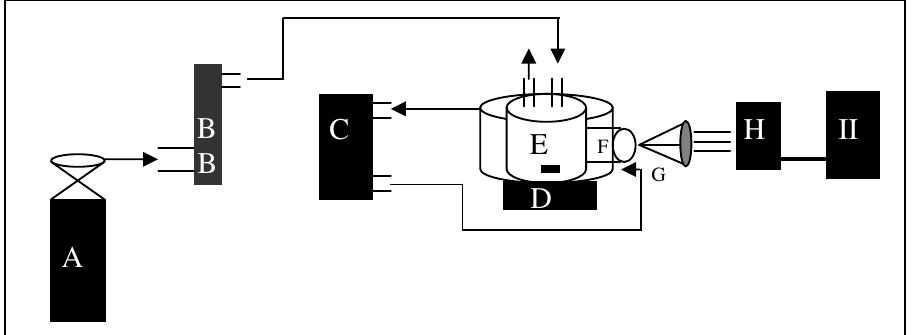
Figure 1 . Schematic diagram of the experimental apparatus for photocatalytic reaction. (A) gas container, (B) gas flow meter, (C) circulating water thermostat (D) magnetic stirrer (E) quartz cell, (G) lenses, (H) low pressure mercury lamp, (I) power supply unit